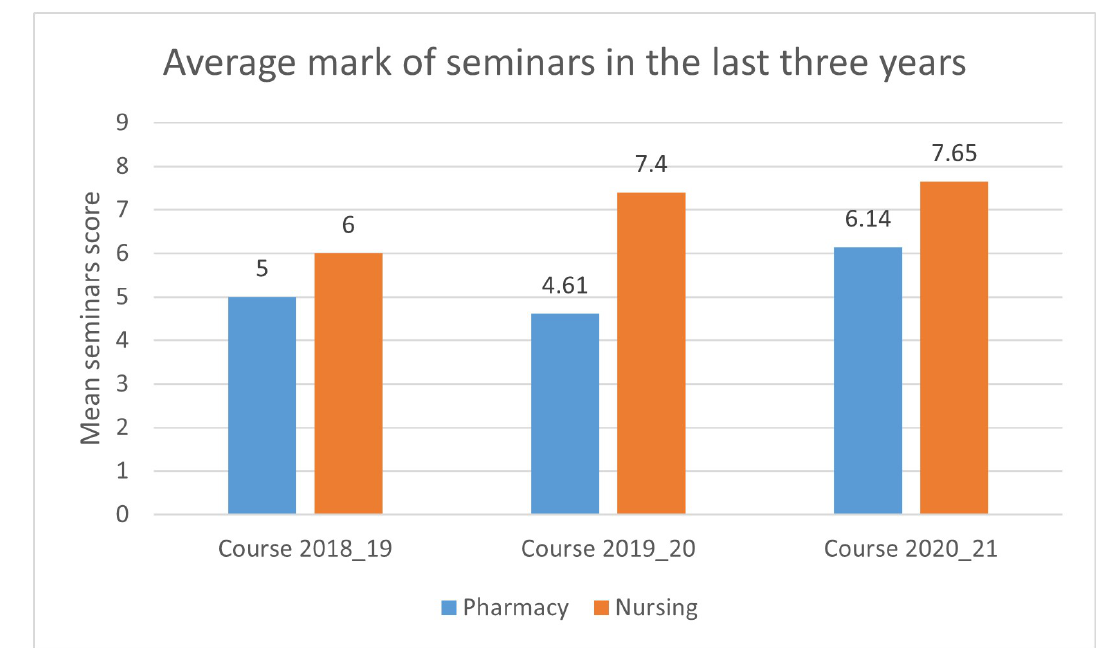
Figure 1. Average mark of seminars in the last three years.